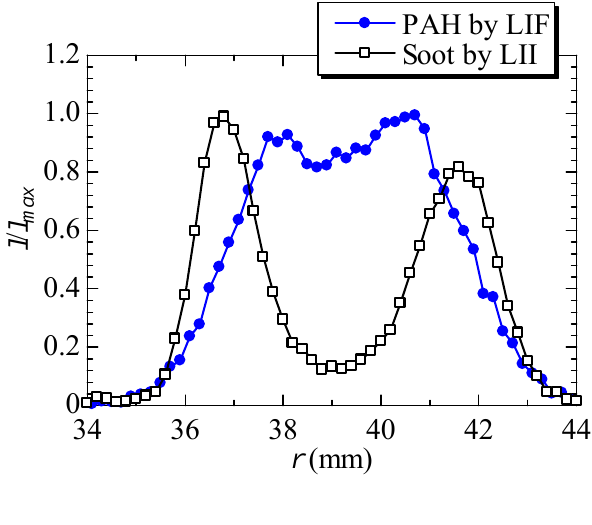
Figure 6. Profiles of PAH-LIF and LII signals in the triple port burner at z =